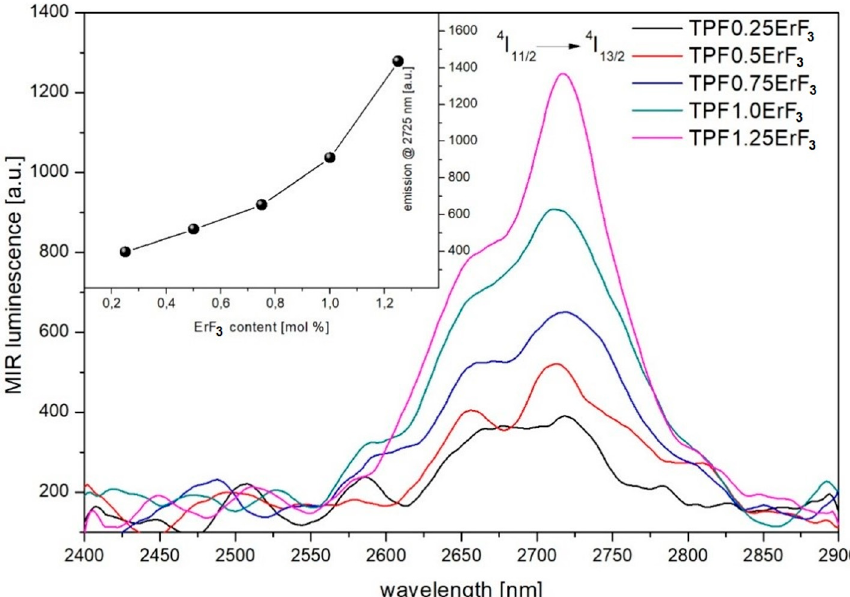
Figure 13. 2725 nm emission spectra of oxyfluoride phospho-tellurite glass with varying ErF 3 content. (inset) The intensity changes of 2725 nm emission band as a function of ErF 3 concentration.